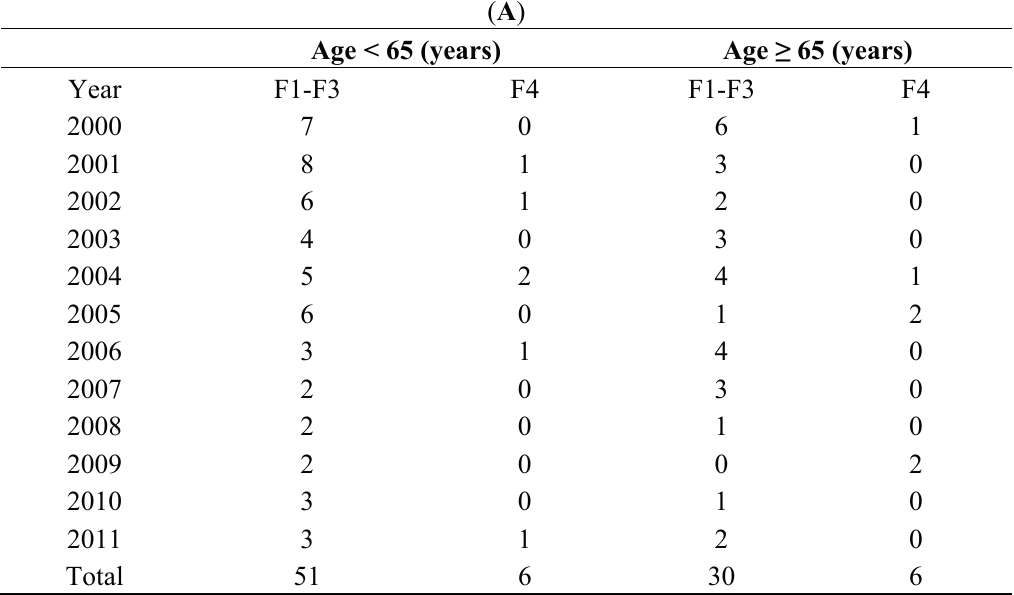
Table 4. Histopathological findings of the liver in autoimmune hepatitis according to age in the present study. ( A ) Staging of fibrosis; ( B ) Grading of inflammatory